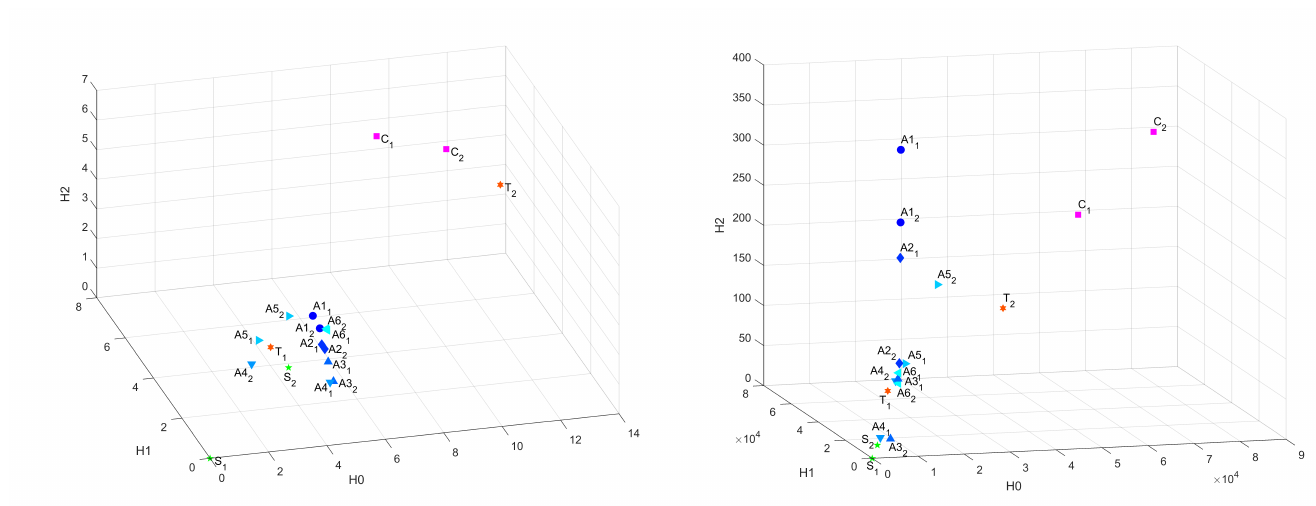
Figure A1. 3D-plot of common distances in Bottleneck and Sliced Wasserstein